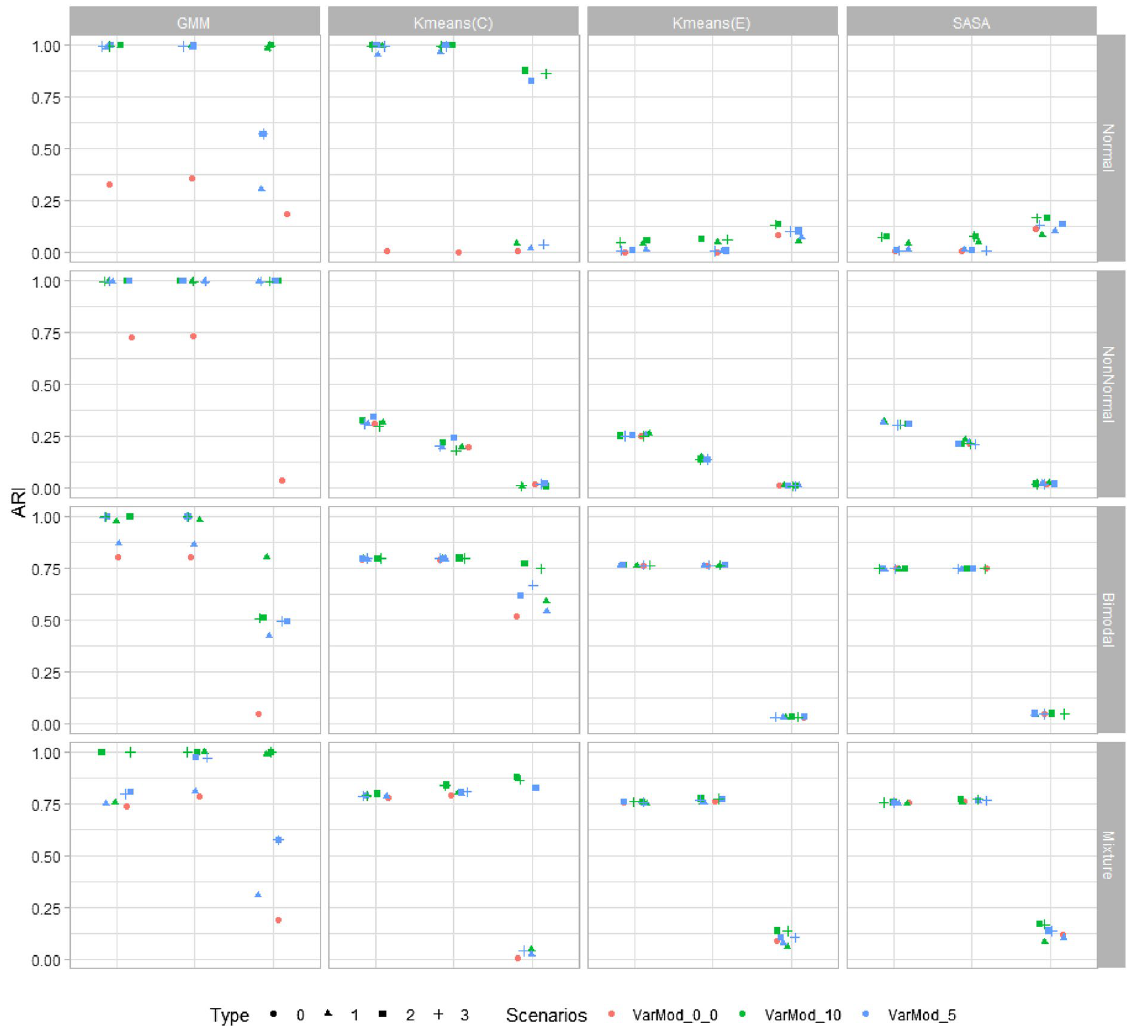
Figure 4. A plot of simulation results for the two clusters problem. All four clustering methods (GMM, K-means(C), K-means(E), and SASA) were tested on synthetic data with two clusters. The performance of clustering methods is monitored based on their adjusted rand index (ARI) value. In the above figure, the ‘Scenarios’ represent the number of variables with updated mean values in synthetic data, such as VarMod_0, all variables in synthetic data with zero mean; VarMod_10, 10 variables in synthetic data with mean value 0.5; VarMod_5, 5 variables in synthetic data with mean value 0.5. And the ‘Type’ represents the nested conditions with scenarios (0, all variables with mean 0; 1, variables with updated means in single cluster (VarMod_0_5, VarMod_0_10); 2, variables with updated means in both clusters (VarMod_5_5, VarMod_10_10); 3, simulation with added noise (VarMod_5_5_addnoise, VarMod_10_10_addnoise). The details of the statistical and spatial parameters modified are given in Fig. and preprocessed in a similar fashion which results in final data dimensions of 260 × 134 × 738. All clustering and dimension reduction methods are implemented on this newly processed MSI data. Overall, the clustering results and conclusions are similar (Supplementary Fig. S5) in low- and high-dimensional spaces except for the t-SNE. The clusters identified in the t-SNE space are better when we used low mass binning size or more molecu- lar ions in our data. In the second scenario, MSI data were preprocessed using another peak-picking method called “simple” from the R-Cardinal package. Together with peak-picking, the remaining pre-processing steps (peak alignment, peak filter, mz alignment, mz bin, and filter) are performed using the Cardinal R package. The tolerance value for peak and mz alignment is set to 50 (in ppm). The total ion current (TIC) was performed to adjust the difference between spectra. A total of 9029 peaks were identified from the MSI data. The final data dimension is 260 × 134 × 9029. Unfortunately, all the results are not reproducible on this dataset. MNF transform failed on the MSI of very high dimensionality. On performing PCA and GMM clustering on a new dataset, the clustered image obtained is a slightly improved version of the image obtained with low-dimensional MSI data (Supplementary Fig. S8). Results from MSI data2: The results are produced using the same set of clustering and dimension reduction techniques (Supplementary Fig. S7). The MSI data was clustered with five clusters (as proposed in the original